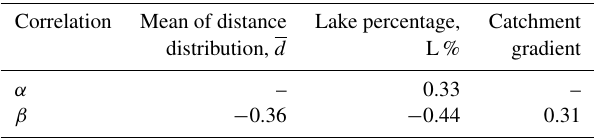
Table 3. Root mean square error (RMSE) values for the mean and standard deviation of simulated ˙ (cid:51) for the 73 catchments. RMSE mean (cid:51) RMSE SD (cid:51)